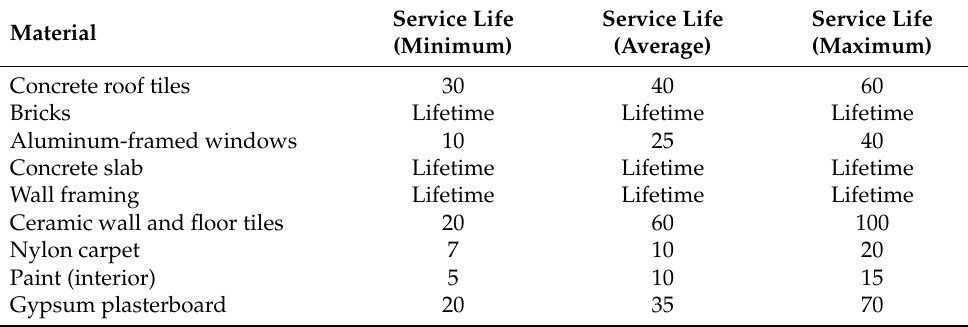
Table 4. Minimum, average and maximum service life values for selected